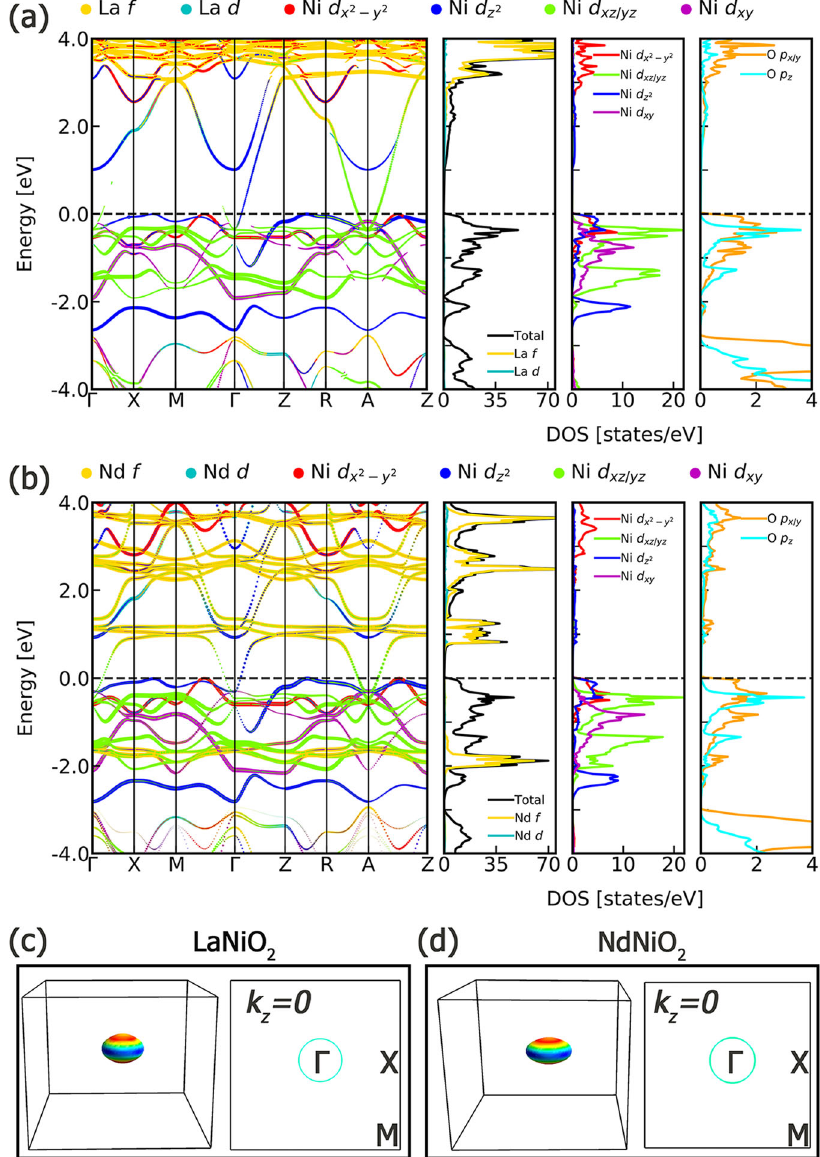
Fig. 4 The calculated electronic structures and Fermi surfaces of G -type antiferromagnetic ( G -AFM) phase. Orbitally-projected electronic structures of the G -AFM phase of a LaNiO 2 and b NdNiO 2 . Band structures are unfolded into the primitive 1 × 1 × 1 Brillouin zone. c Fermi surface of LaNiO 2 and its projection of on the k z = 0 plane. d Same as c but for NdNiO 2 . Red and blue colors identify portions of the Fermi surface where the Fermi velocity is maximum and minimum, respectively. The Fermi velocity lies in-between the maxima and minima in the green